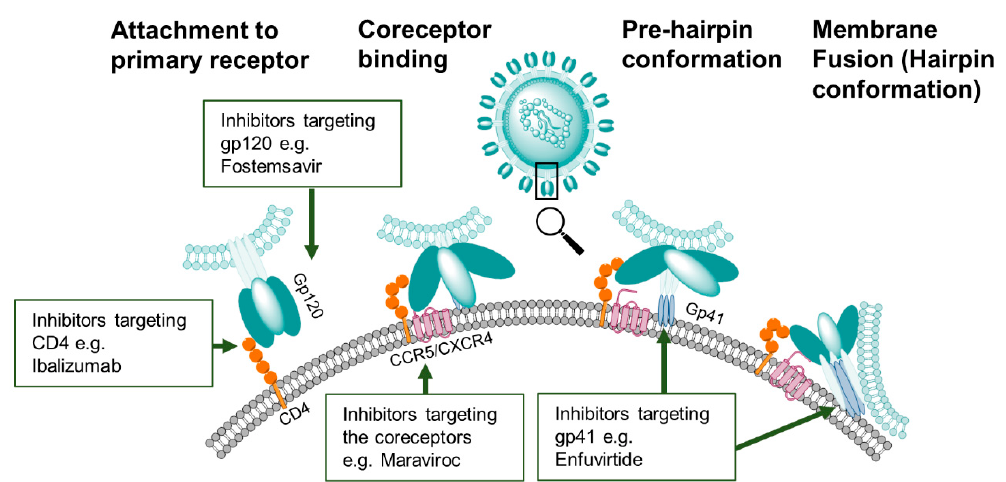
Figure 3. HIV-1 entry inhibitor targets. Compounds that inhibit the first stage of viral binding target epitopes on the primary receptor CD4 or on gp120. Other classes of entry inhibitors target subsequent conformation states of the Env trimer to block CCR5/CXCR4 co-receptor binding or gp41-mediated membrane fusion.